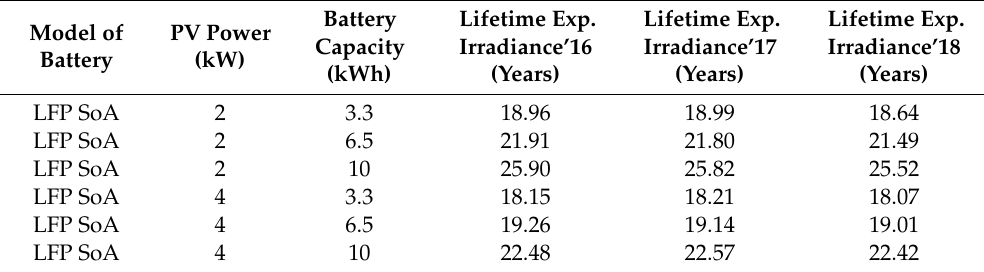
Table 4. Lifetime expectancy results for the LFP state-of-the-art battery pack installed at household 3 analyzed with irradiance data from three successive years in location A.